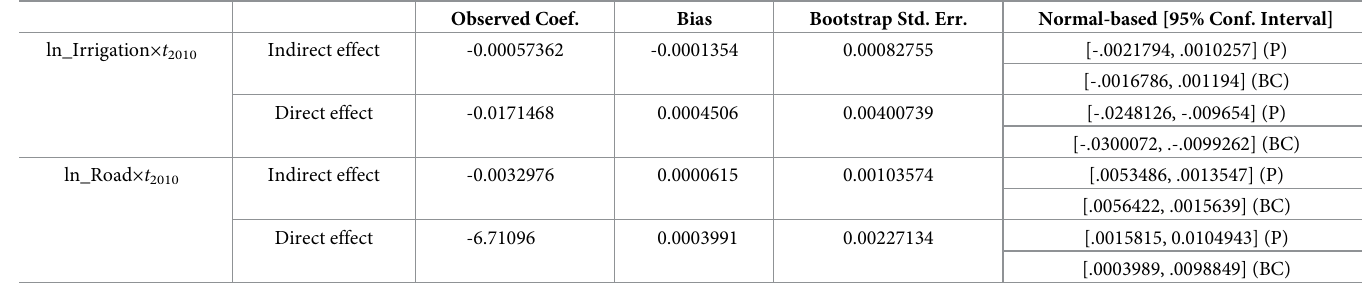
Table 9. Result for bootstrapping.